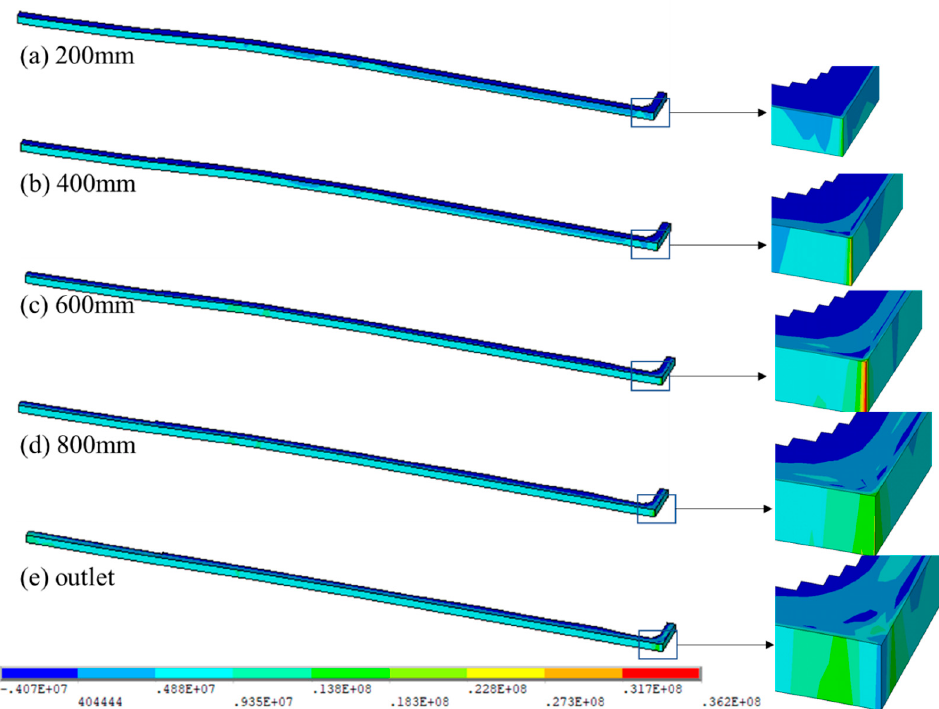
Figure 6. ( a − e ) Distribution of the first principal stress of the shell at different heights from the mold meniscus.